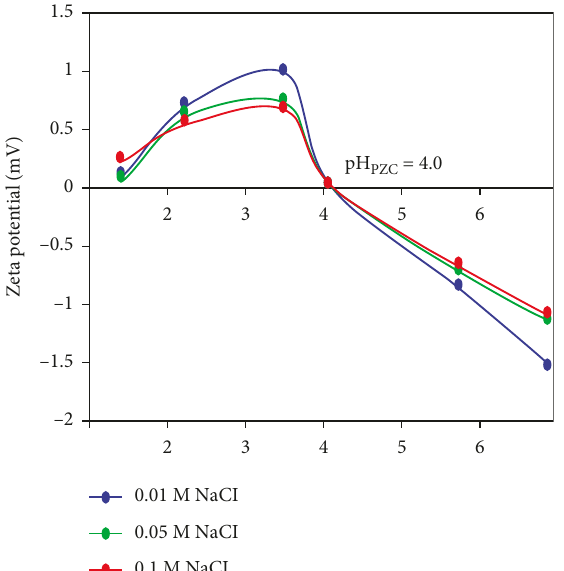
Figure 1: Determination of point zero charge using 0.01 M, 0.05M, and 0.1M NaCl.